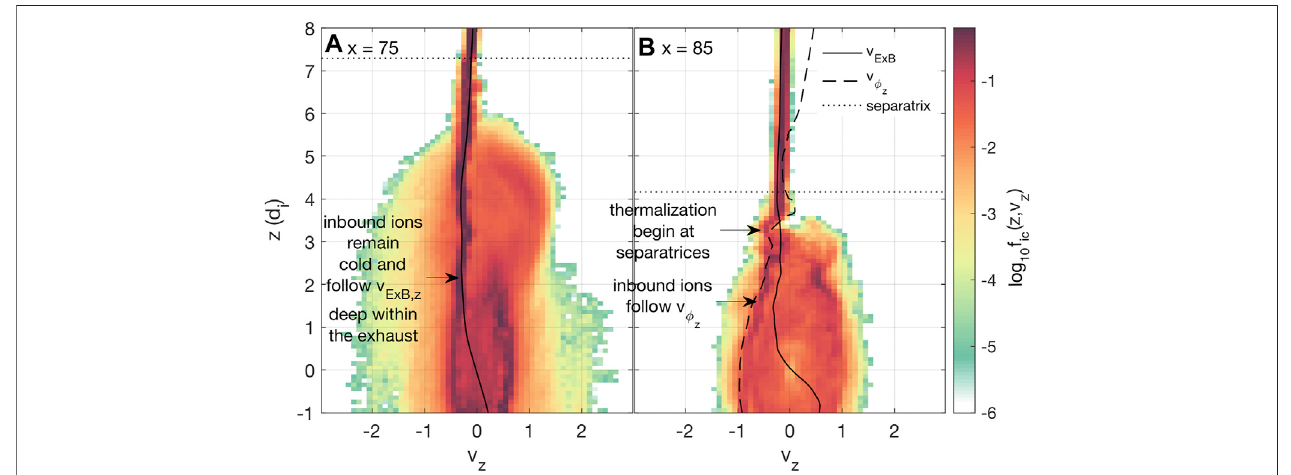
(cid:6)(cid:6)(cid:6)(cid:6)(cid:6)(cid:6)(cid:6) (cid:8) (cid:1) 2 e ϕ z / m i , where ϕ z (cid:1) z (cid:1) 75, the cold inbound ions remain cold and follow v E × B , z deep within the . The thermal population consists largely of ions that have already z